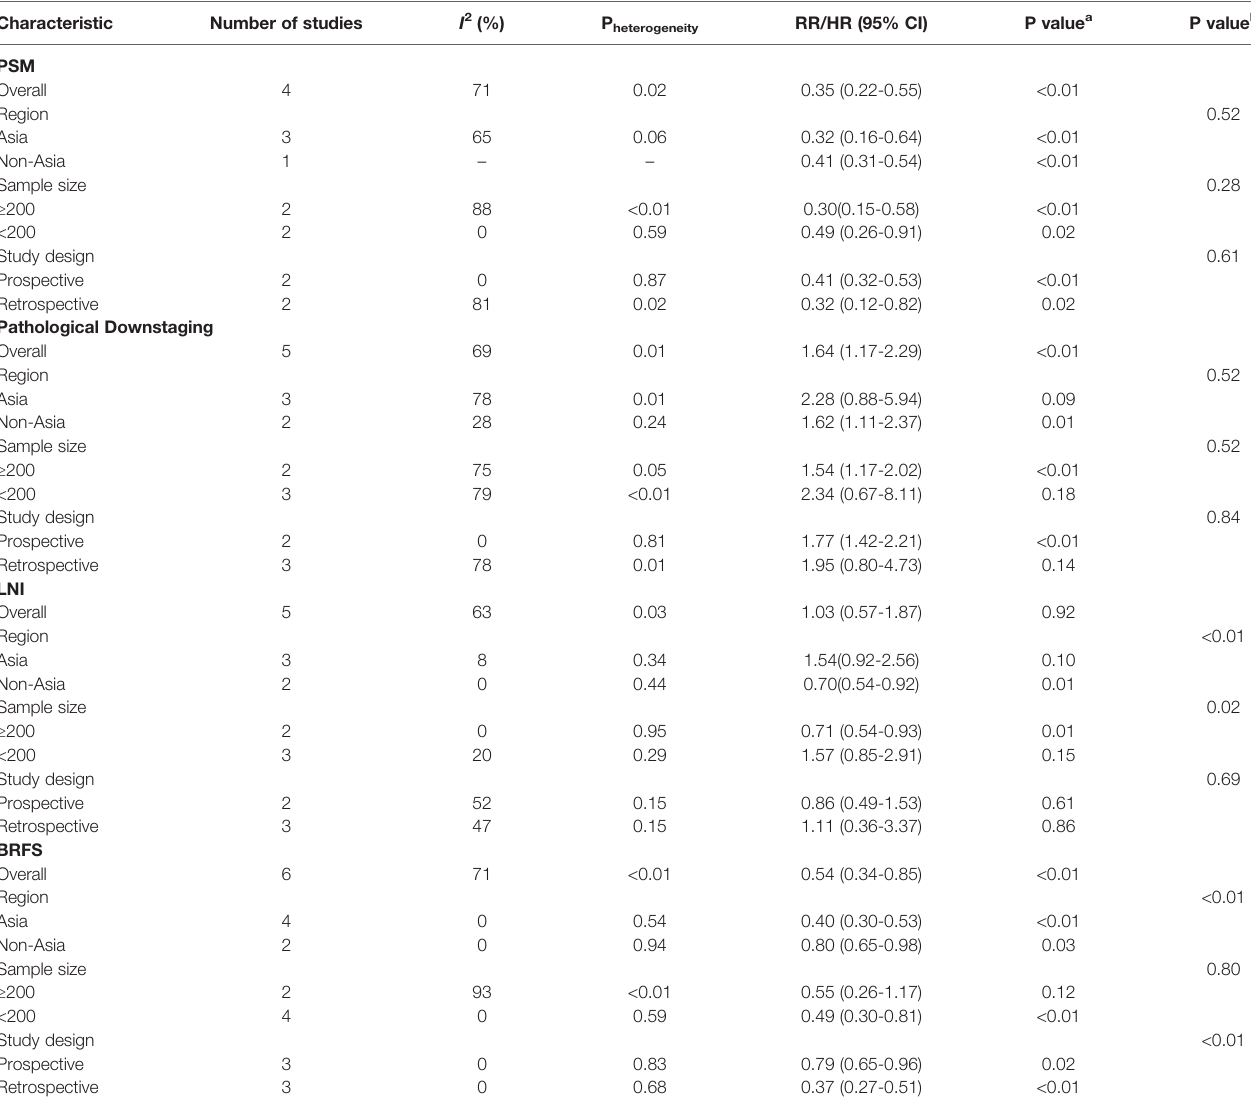
TABLE 2 | Subgroup analyses of selective outcome indicators according to sample size, region, and study design.